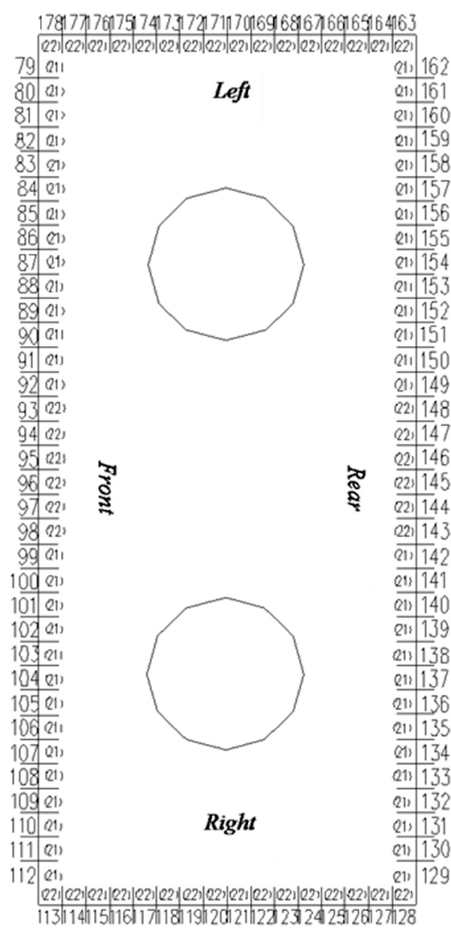
Figure 9. Schematic of Vertical Circuit Division of Upper Furnace.